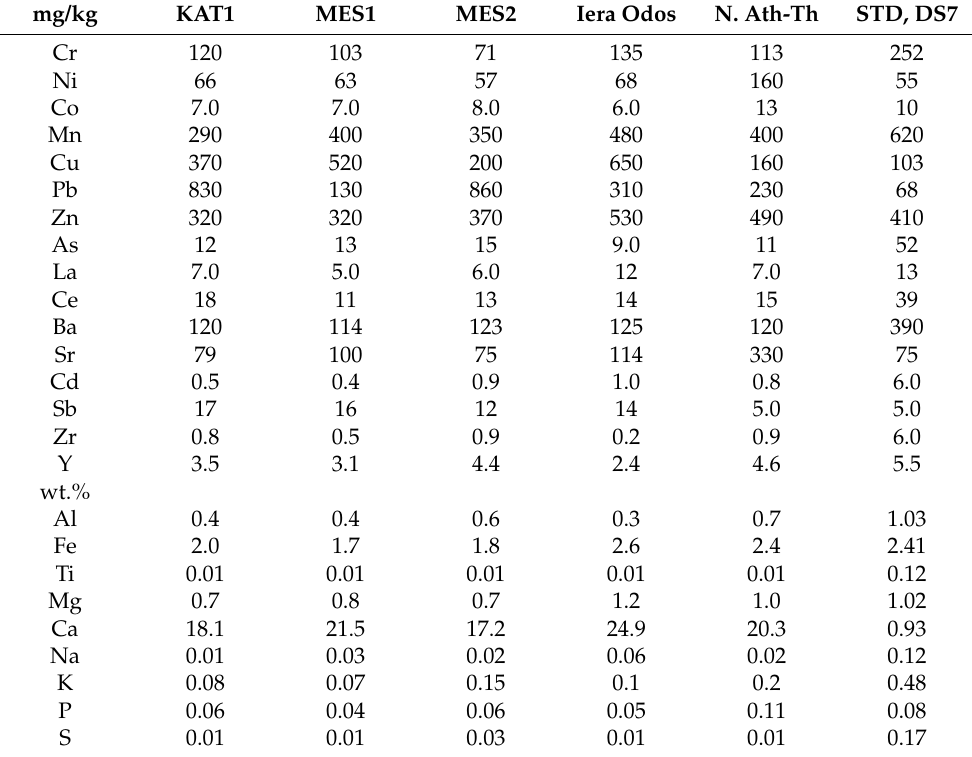
Table 4. Trace element contents in dust samples along roadsides of the Athens